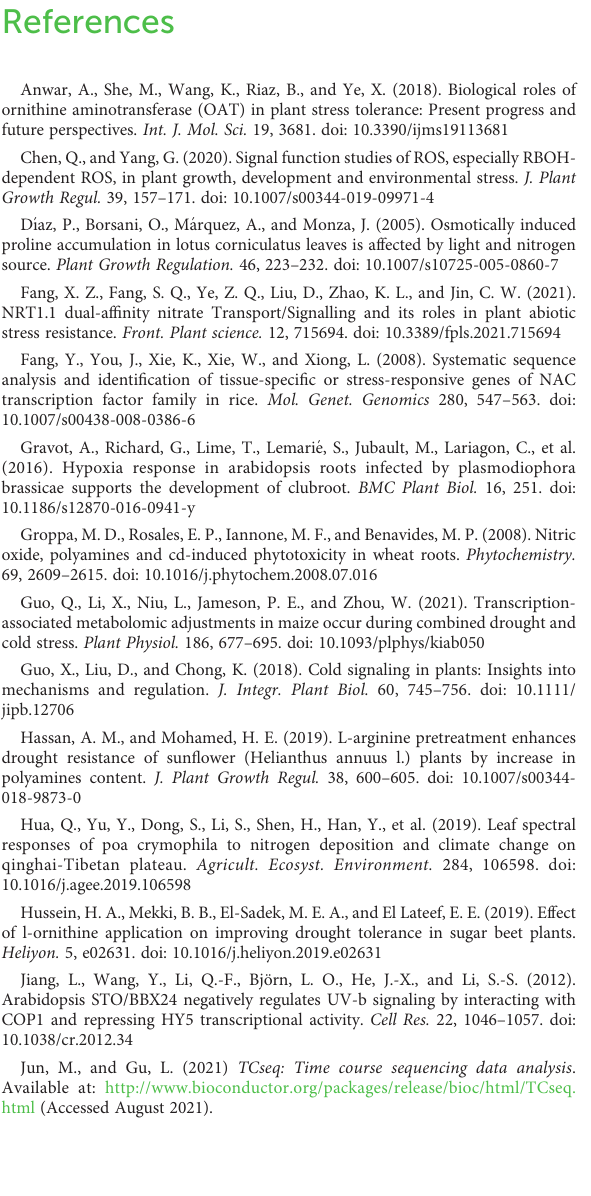
SUPPLEMENTARY TABLE 1 Gene expressions of P. crymophila and expression differences SUPPLEMENTARY TABLE 2 Gene Expression Clusters. SUPPLEMENTARY TABLE 3 The results of consensus analysis. SUPPLEMENTARY TABLE 4 The results of module preservation analysis. SUPPLEMENTARY TABLE 5 The results of cold and drought co-expression network.